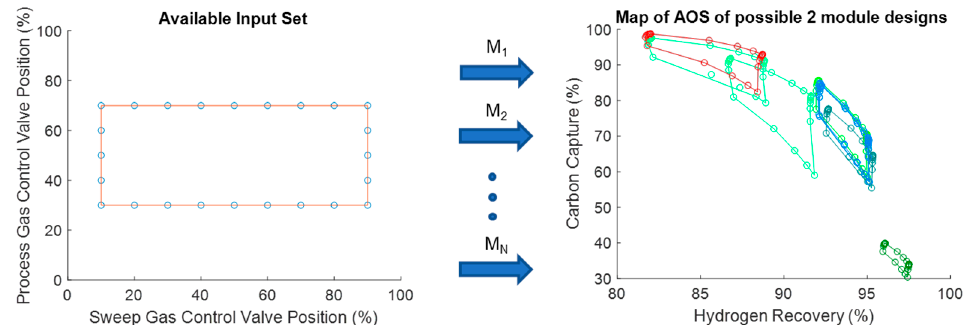
Figure 9. Plot showing all viable 2-mod design AOS’s given the same AIS. Here, the red AOS represents the membrane reactor AOS that is shown in Figure 8. In addition, M 1 , M 2 , . . . M N , denote the mapping of each module-based design.